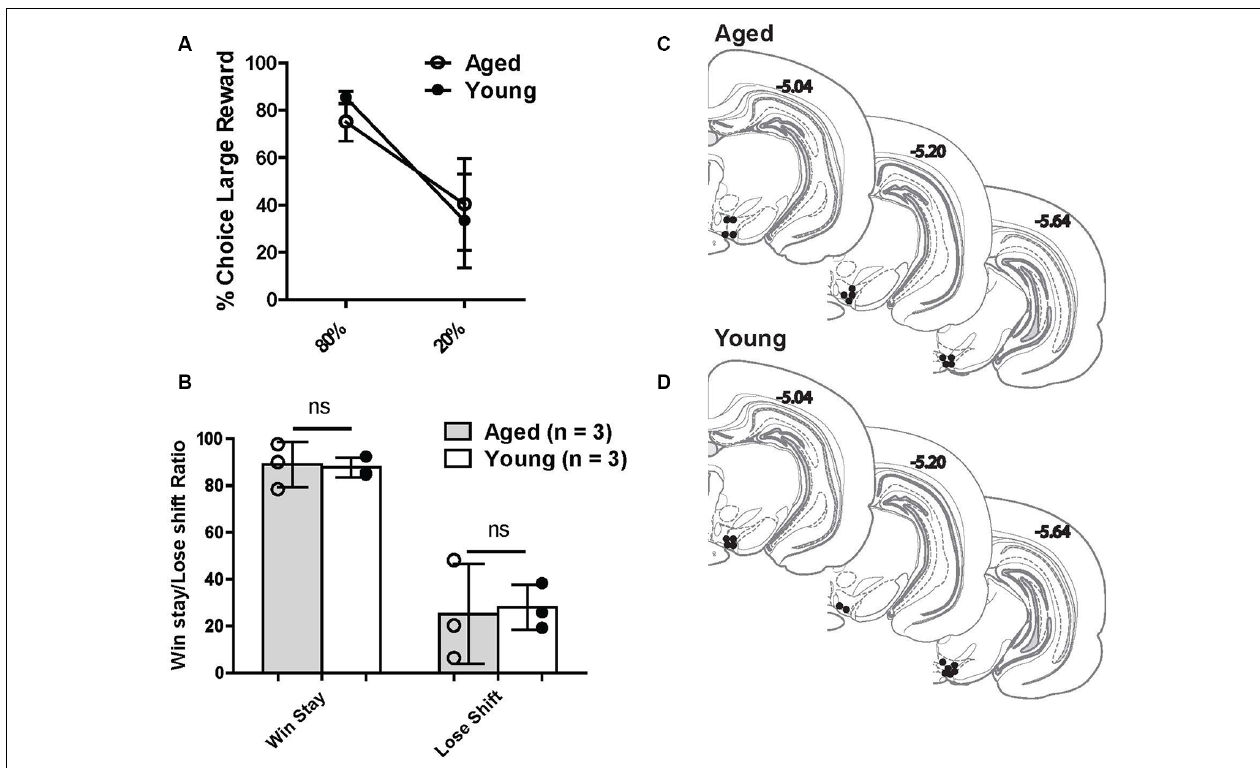
FIGURE 4 | (A) Risk-based decisions by age group for recording experiment: mean ( ± SEM) choice of large rewards for 80% and 20% probability blocks grouped by age. Scores reflect rats’ choice of the large reward lever during the choice trials. There was no significant difference in choice behavior between age groups. (B) Win-stay and lose-shift choice behavior for aged and young rats. Open circles: aged rats, n = 3; Closed circles: young rats, n = 3. (C,D) Histological reconstruction of terminal tetrode tip locations in aged and young rats. ns = not significant, p >